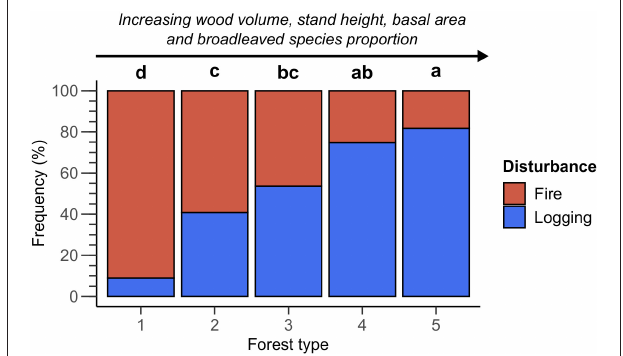
FIGURE 6 | Relative frequency of burned and logged transects for the five forest types identified. Lowercase letters (a–d) above the bars indicate if the disturbance frequencies between forest types are significantly different. Two forest types are significantly different when they show different letters. Details of the pairwise chi-square test are provided in Appendix D